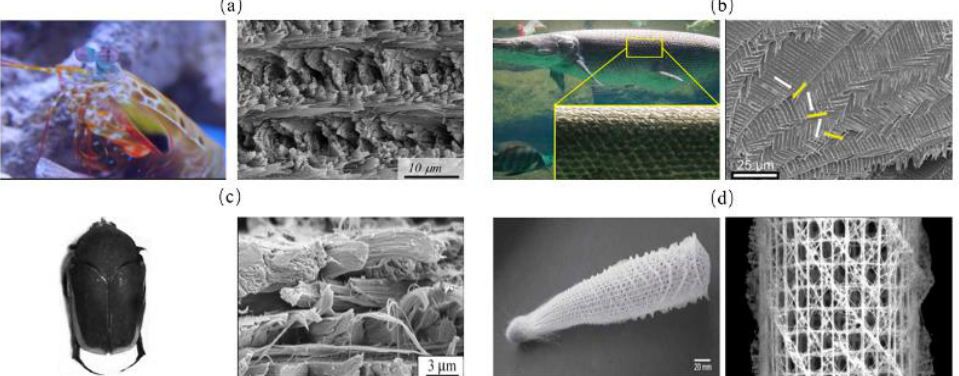
Figure 7. Schematic diagram of the helical model.